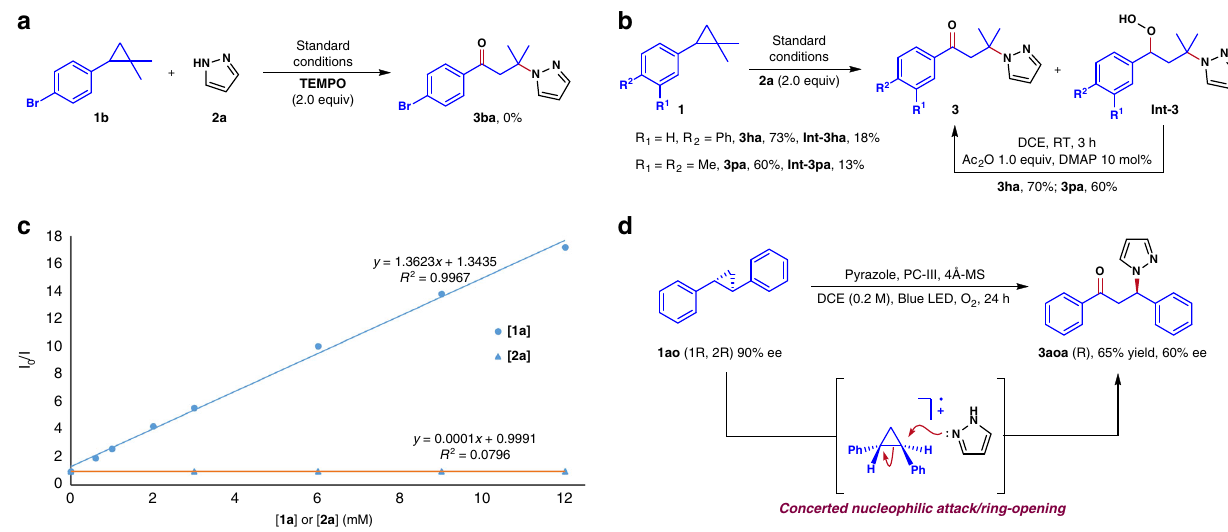
Fig. 3 Mechanistic investigations. a Inhibition by TEMPO of the reaction between 1b and 2a . b Isolation of hydroperoxide intermediates and their conversion to the products 3 . c Stern – Volmer fl uorescence quenching study of 1a and 2a . d Experiments with enantiomerically enriched 1ao . DCE 1,2- dichloroethane, MS molecular sieves, DMAP 4- N,N -dimethylaminopyridine